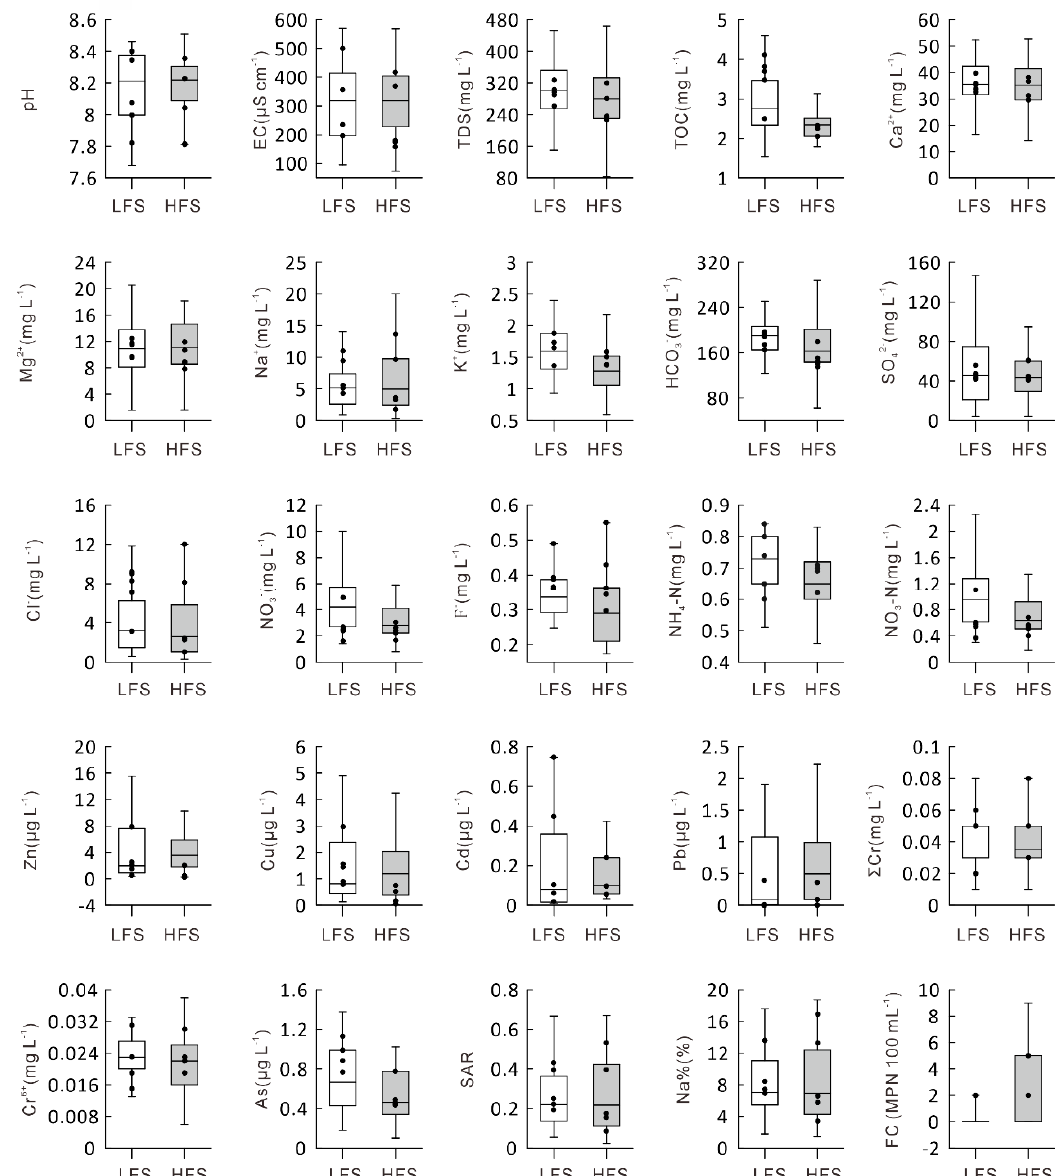
Figure 2. Hydrochemistry of the river water samples from the upper reaches of the Syr Darya River system during the high-flow season (HFS) period (filled with a black color, n = 38) and the low-flow season (LFS) period (filled with a white color, n = 38). The data of the main channel of Syr Darya River were marked with solid dots.